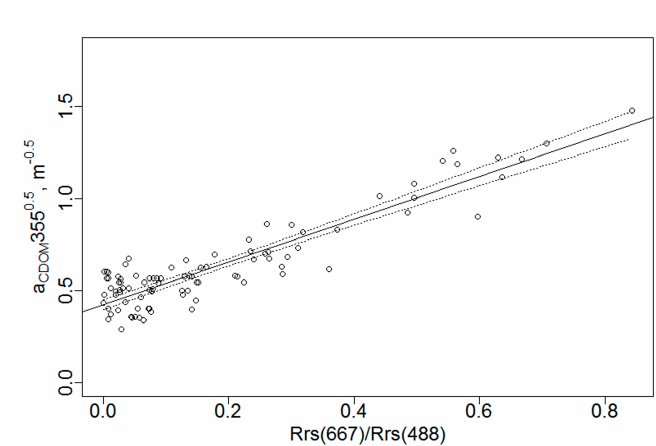
Figure 8. Plot of the in situ a CDOM 355 values versus the in situ band ratio R rs (667)/ R rs (488) of the test data set. The solid and dashed lines are the GLS fitted Model 3 and the 95% confidence interval,